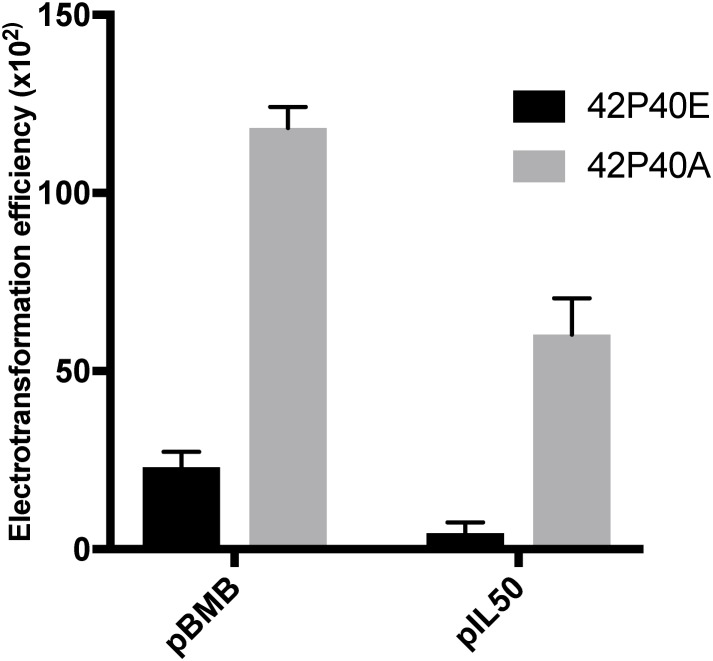
Competence. Electrotransformation efficiency (CFU/μg DNA) of 42P40A (black) and 42P40E (gray) clones after electroporation with plasmids recovered from S. aureus (pBMB) or E. coli (pLI50) (p < 0.001, two-way ANOVA).